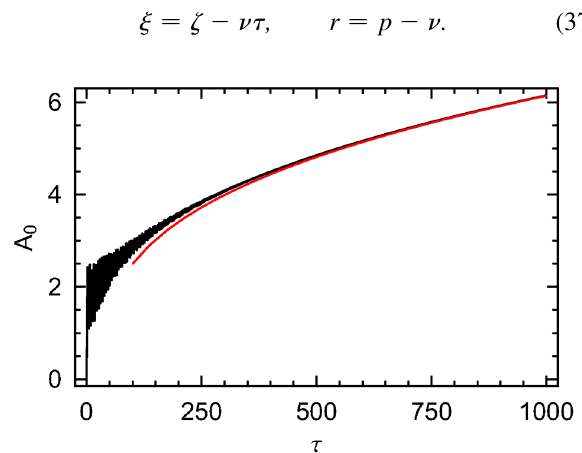
FIG. 3. (Color) The absolute value of the amplitude j A (cid:7) 0 (cid:8)j as a function of 0 . Black curve: result of simulation; red curve: analytical solution of Eq.